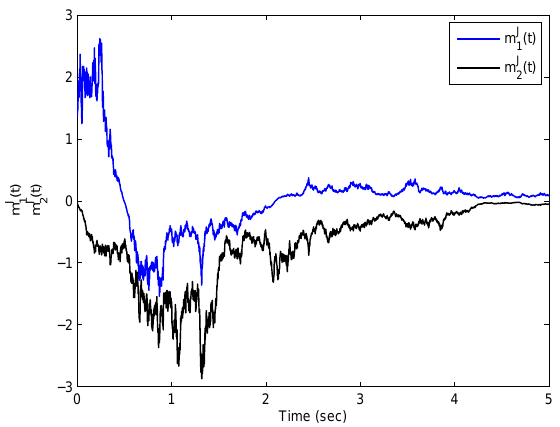
( t ) pertaining to the SMQVNN ( t ) , m J 2 1